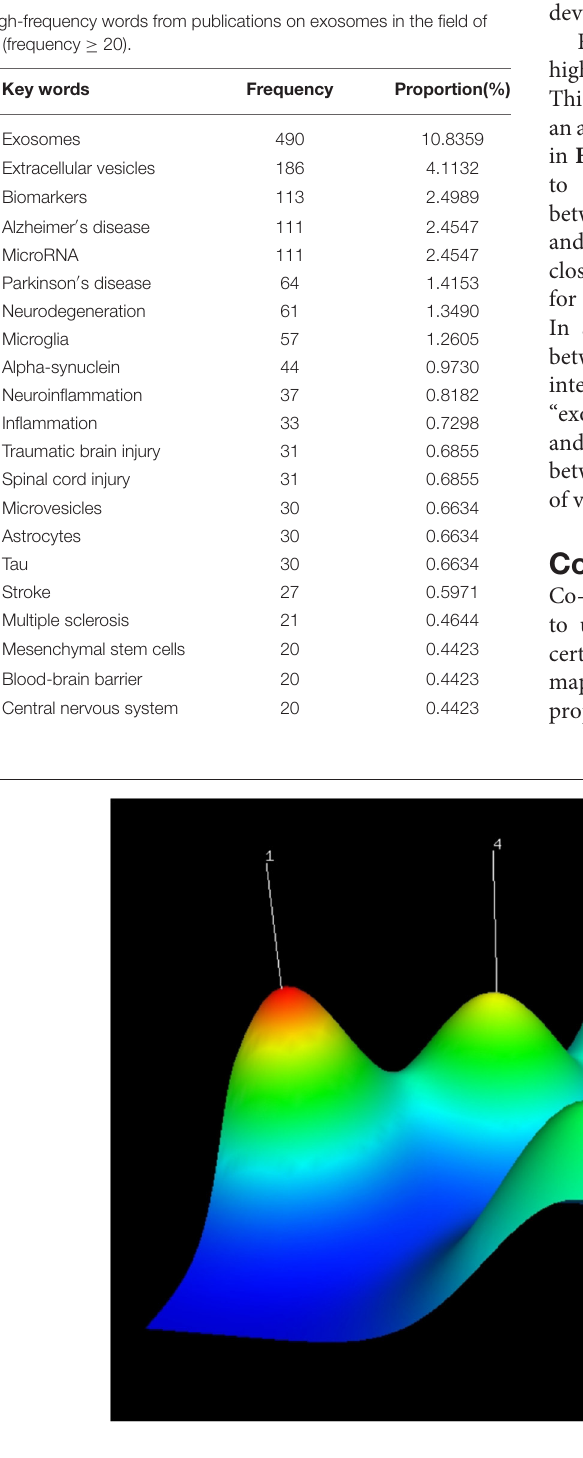
FIGURE 4 | Mountain visualization of biclustering analysis results of high-frequency words about exosomes in the field of neuroscience.